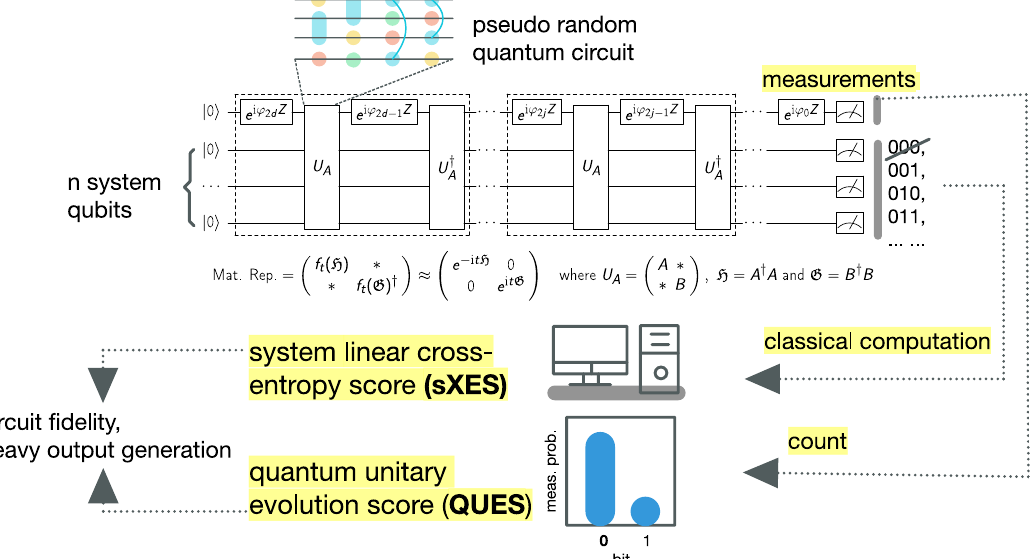
Fig. 1 Illustration of the minimal quantum singular value transformation (mQSVT) circuit for the Hamiltonian simulation benchmark. The overall circuit implements a complex matrix polynomial f t ð H Þ of degree d on the Hamiltonian H that is de fi ned in terms of a pseudo random quantum circuit U A . The circuit acts on n + 1 qubits, consisting of n system qubits and 1 ancilla qubit. After measuring the top ancilla qubit and post-selecting on the 0 outcome of this, the action on the bottom n system qubits accurately approximates exp ð(cid:2) i t H Þ 0 n j i